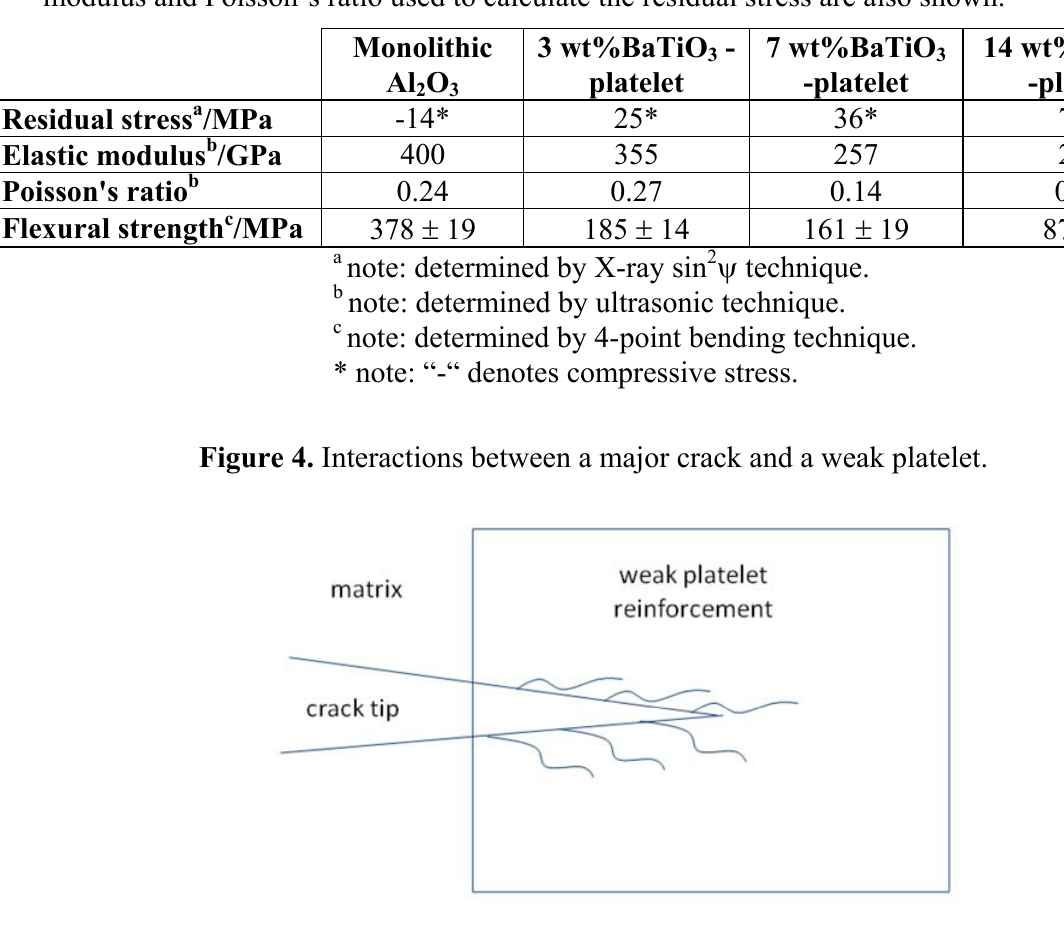
Table 2. Residual stress and strength of Al modulus and Poisson’s ratio used to calculate the residual stress are also shown.